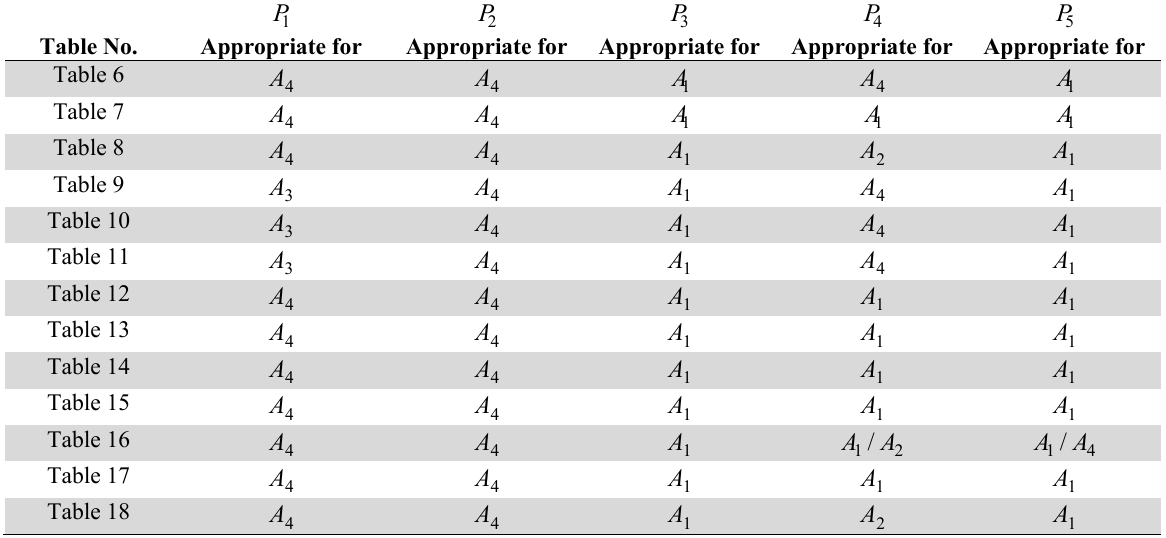
Vertical Decisions taken from Table 6 to 26 Appropriate for Appropriate for Appropriate for Appropriate for Appropriate for